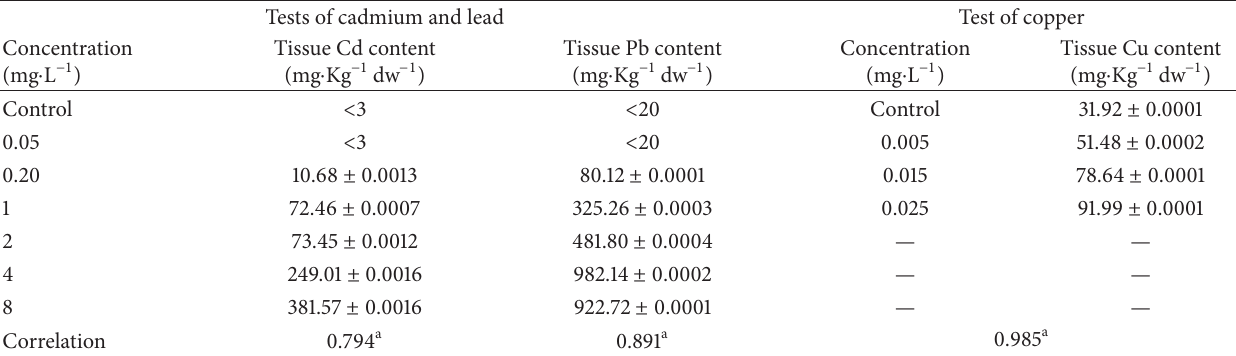
Table 2: Means ( ± SD) of bioaccumulation of different concentrations of cadmium, lead, and copper after 72h exposure and Pearson correlation coefficients between metals exposure and metals